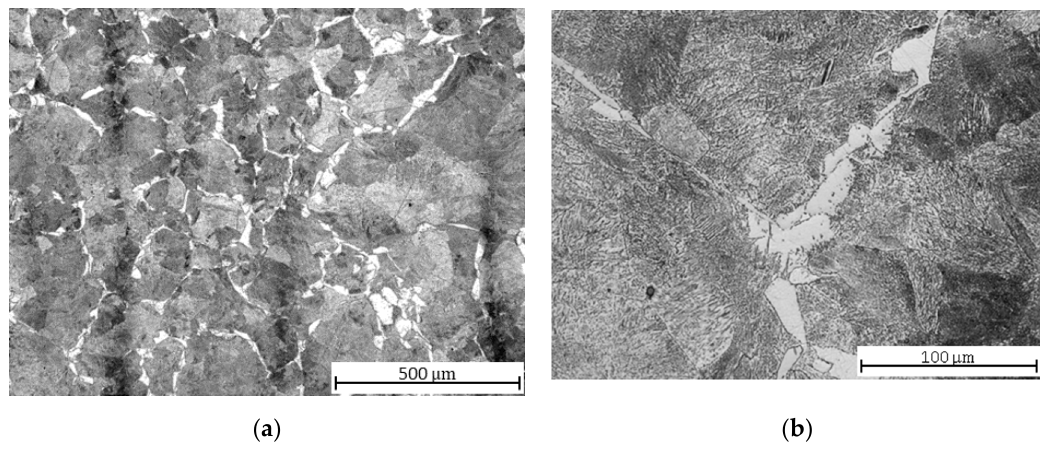
Figure 10. 30CrV9 steel microstructures after soft annealing: ( a ) central part; ( b ) detail.